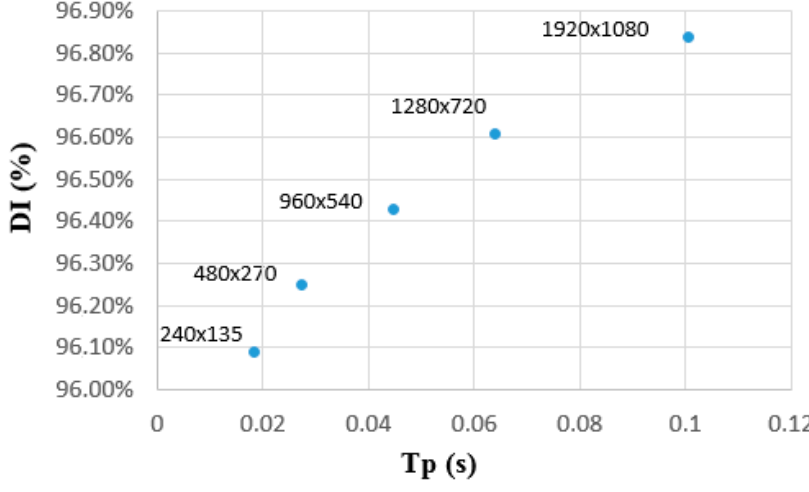
Figure 7. Relation between the general performance of the detection through Dice Index (DI) vs. time processing (Tp) for FFDI performance at different image resolutions.